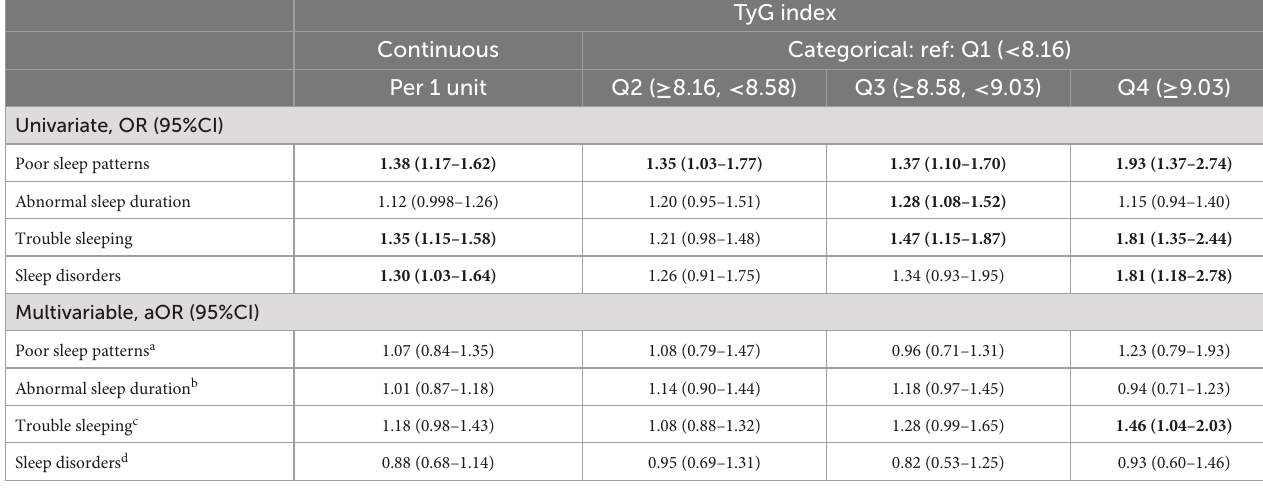
TABLE 2 Associations between TyG index, poor sleep patterns and its components.